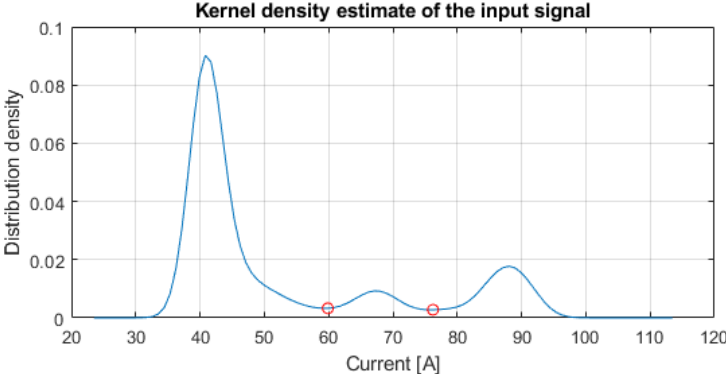
Figure 8. Kernel density estimate of the input signal. Detected thresholds are marked with red